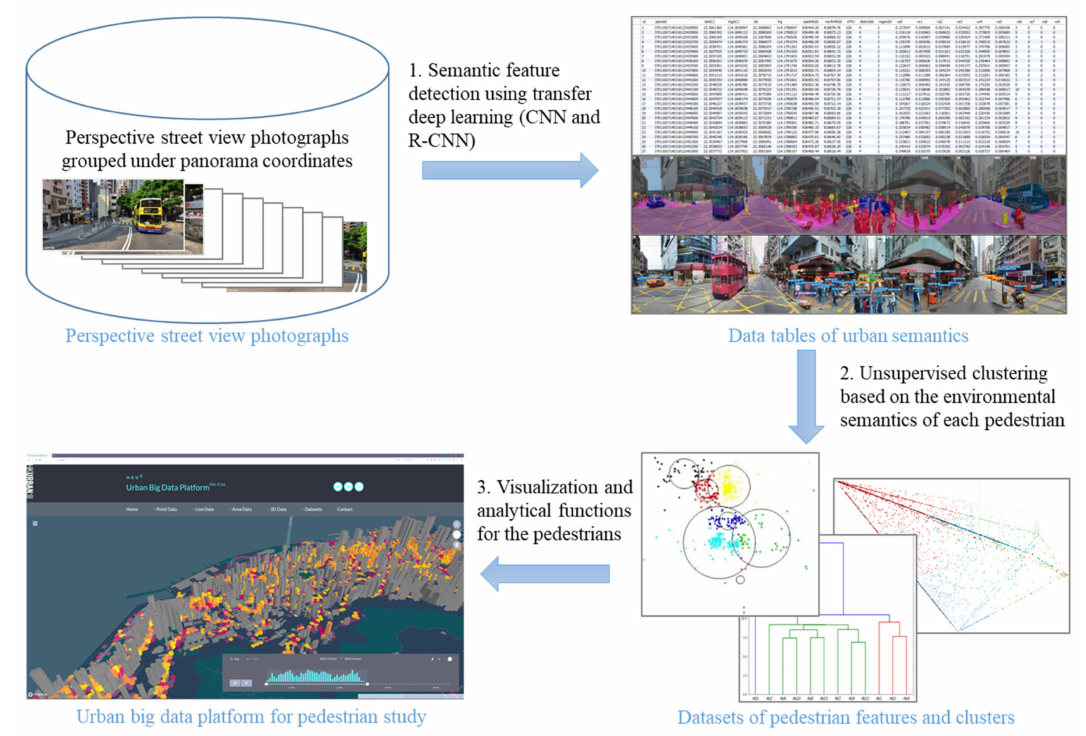
Figure 4. Three steps of the VUCCA approach for pedestrians in street